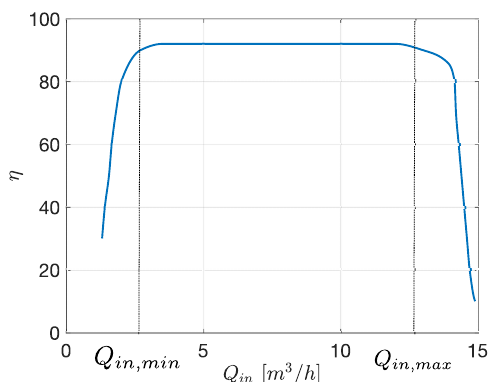
Figure 3: Relationship between efficiency and inflow rate of a hydrocyclone (Husveg et al., 2007). The efficiency of hydrocyclone is defined as η = 1 − β U,o , where β in,o is the volume frac- β in,o tion of oil at the hydrocyclone inlet and β U,o is the volume fraction of the oil at the under- flow outlet (water